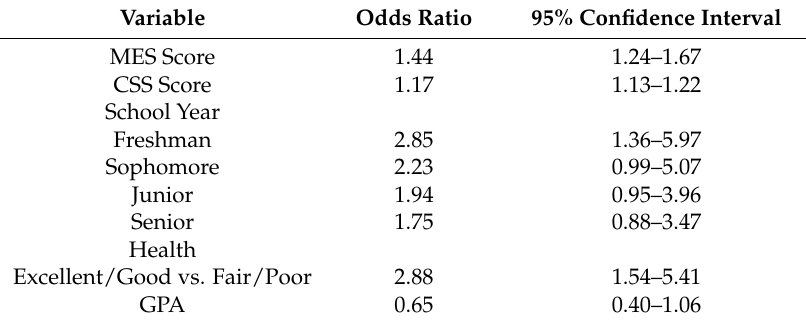
Table 2. Logistic regression model predicting food insecurity in students.